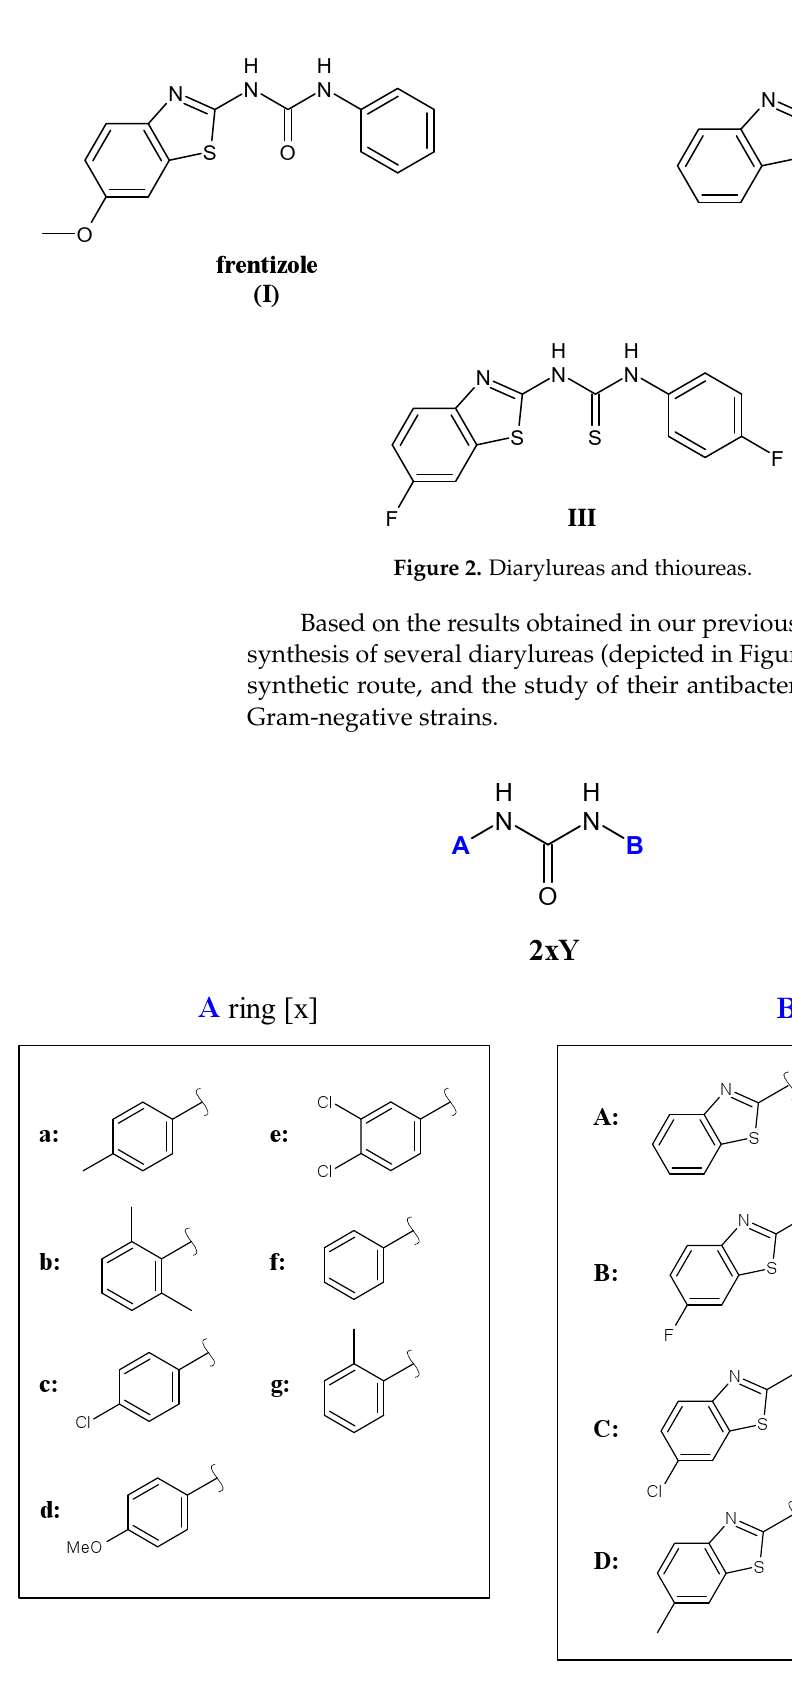
Figure 3. Library composition of diarylureas 2 [x,Y].